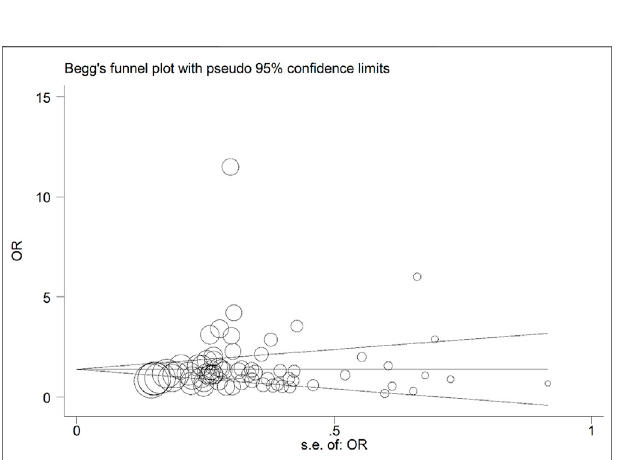
FIGURE 14 | Funnel, Eagers ’ , & Beggs ’ plots for assessment of publication bias.